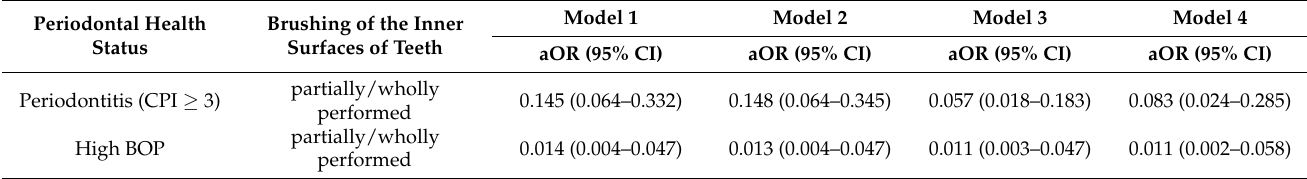
Table 2. Association between brushing of inner surfaces of tooth and periodontal health